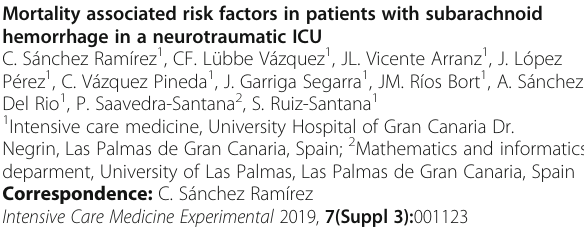
Table 1a (abstract 001123). Characteristics of the patients according survival/death